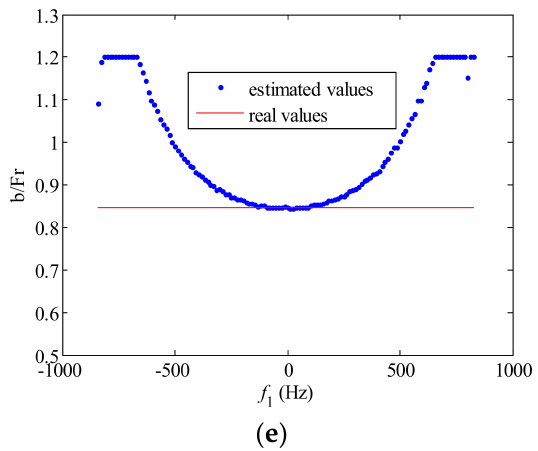
Figure A1. The statistical results of b / F r , estimated by selecting different frequencies. ( a ) f 2 is the first frequency point, which represents the left edge of the Doppler spectrum; ( b ) f 2 is the 30th frequency point; ( c ) f 2 is the 64th frequency point, which is the Doppler centroid frequency; ( d ) f 2 is the 90th frequency point; ( e ) f 2 is the 128th frequency point, which represents the right edge of the Doppler spectrum; f 1 is the whole spectrum in ( a – e